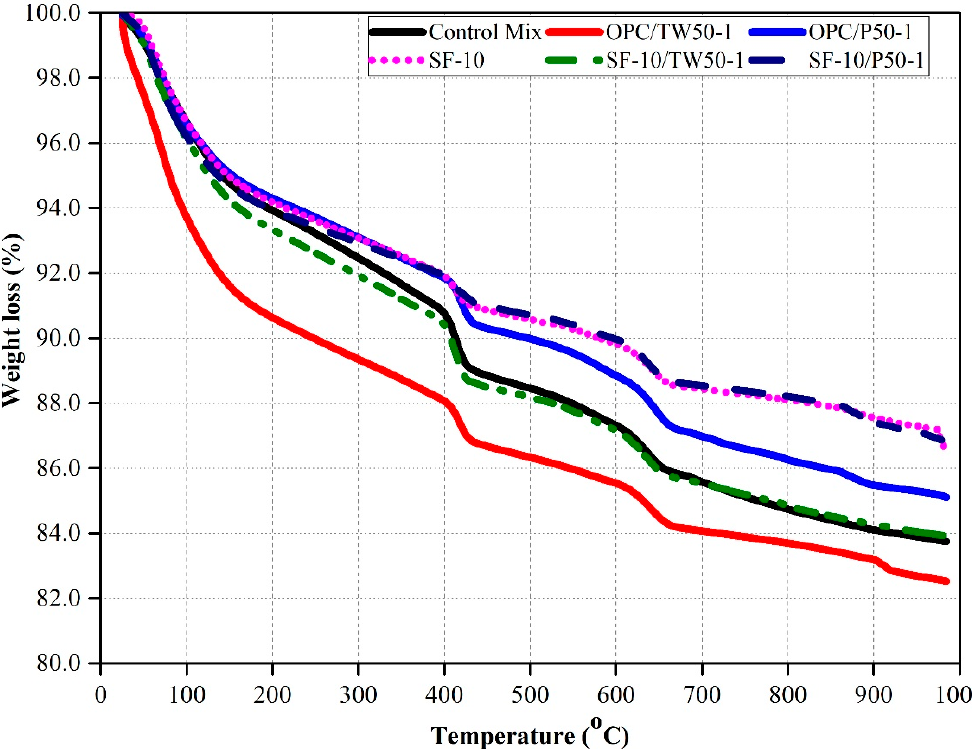
Figure 12. Thermo-gravimetric analysis (TGA) of samples made with tea waste and perlite particles with and without SF after 28 days.